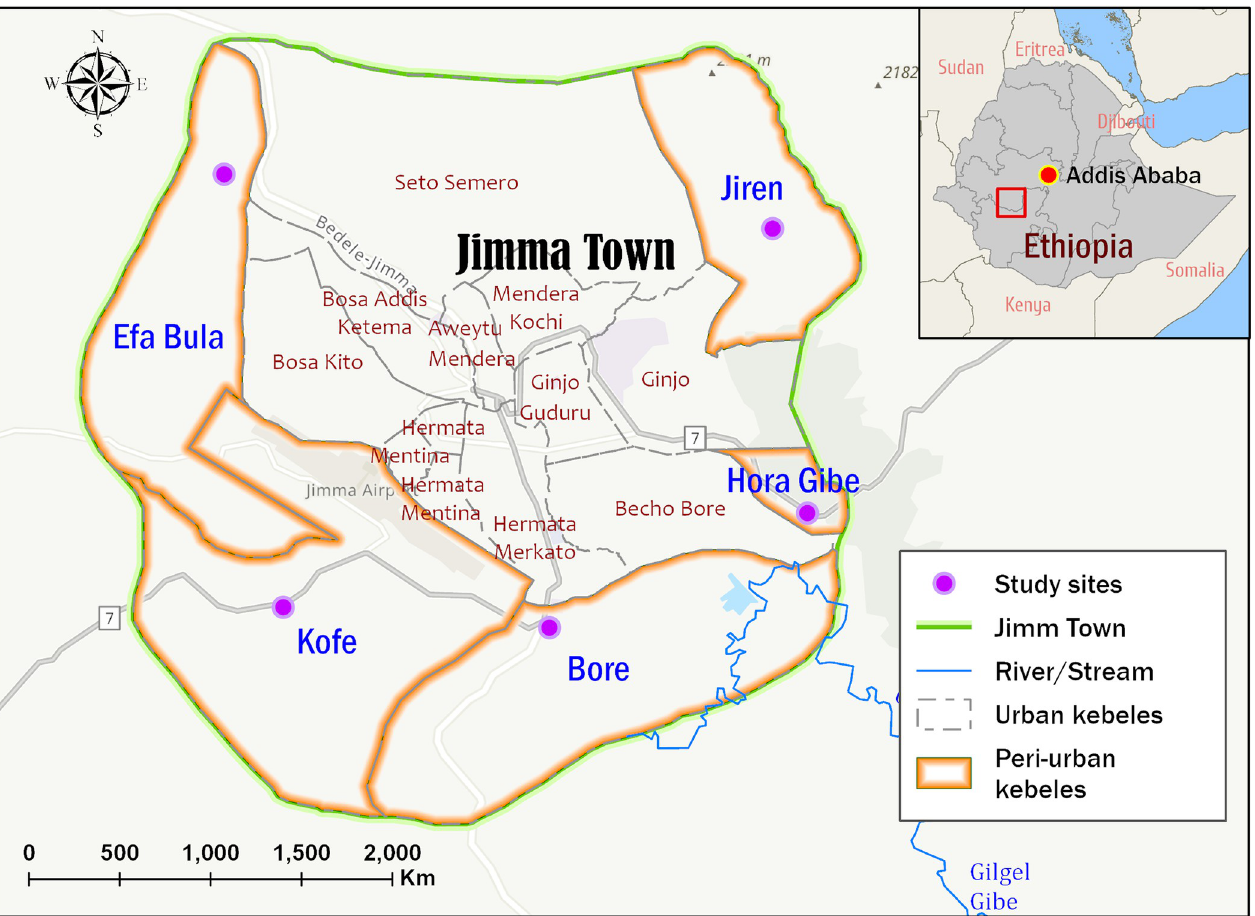
Fig 1. Location of the study sites: The five peri-urban kebeles in Jimma town, Oromia, Ethiopia.